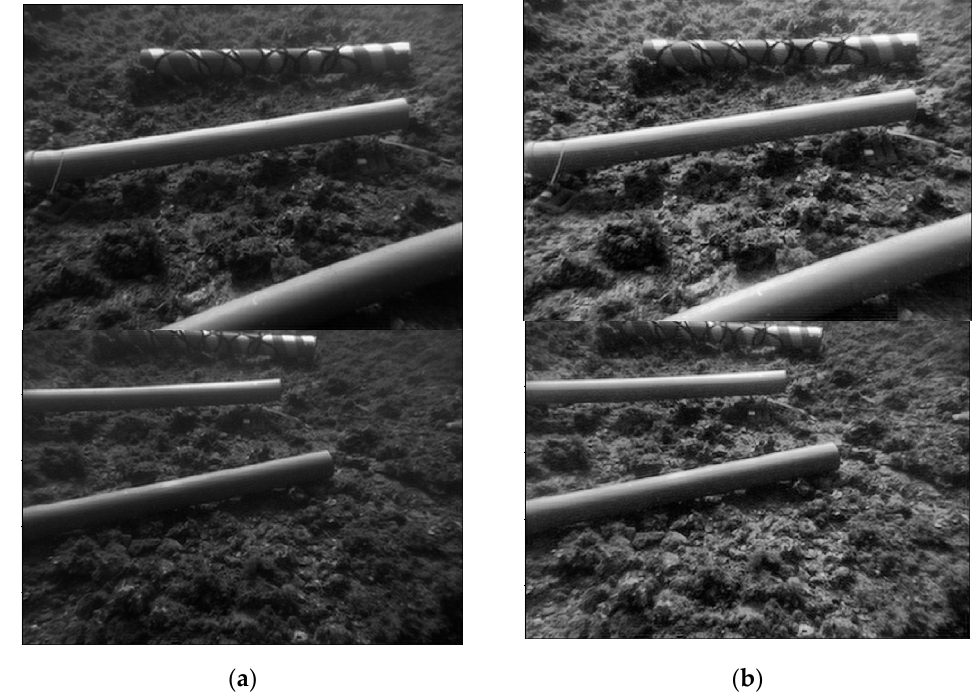
Figure 3. Underwater pipe image enhancement (Mix-CLAHE) ( a ) Original image after noise reduction and ( b ) Output image.